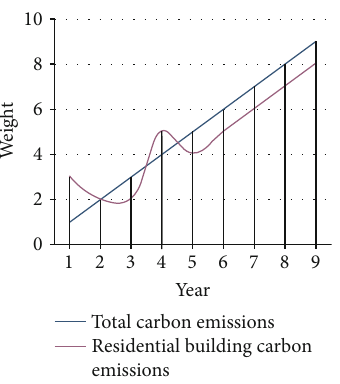
Figure 6: Comparison of carbon emissions between residential buildings and residential buildings.